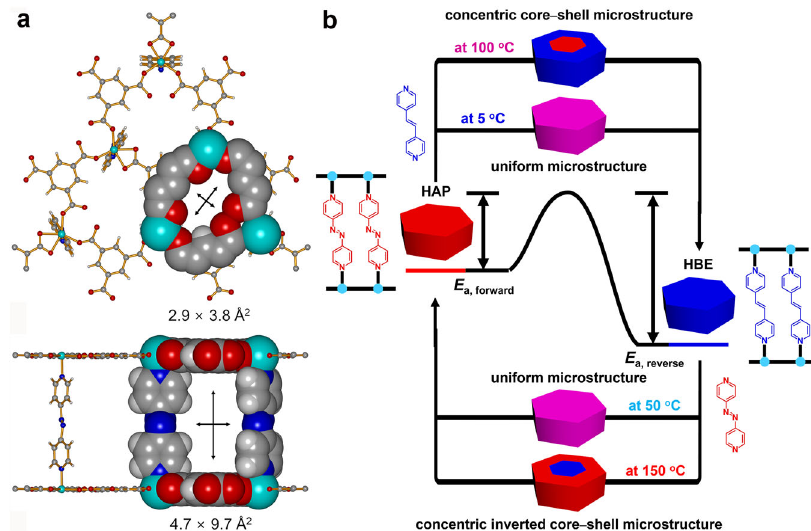
Fig. 1 Pillared 3D MOF and reversible pillar exchange processes. a The pillared 3D MOF, [Ni(HBTC)(AP)] (HAP, where HBTC = benezene-1,3,5- tricarboxylate and AP = azobis(4-pyridine)), with hms topology illustrating portals along the [0 0 1] (top) and [1 0 0] (bottom) directions. b Temperature- controlled reversible pillar exchange between HAP and [Ni(HBTC)(BE)] (HBE, where BE = trans -1,2-bis(4-pyridyl)ethene) via concentric core – shell microstructural intermediates and uniform microstructural intermediates. In ( a ), cyan, red, gray, and light gray of the ball-and-stick and space- fi lling models represent the nickel, oxygen, carbon, and hydrogen atoms, respectively. In the schematic drawings of the concentric core – shell microstructure, concentric inverted core – shell microstructure, and uniform microstructure in ( b ), red and blue indicate the heterogeneous distribution of AP and BE pillars, and pink indicates homogeneous distribution of AP and BE pillars.